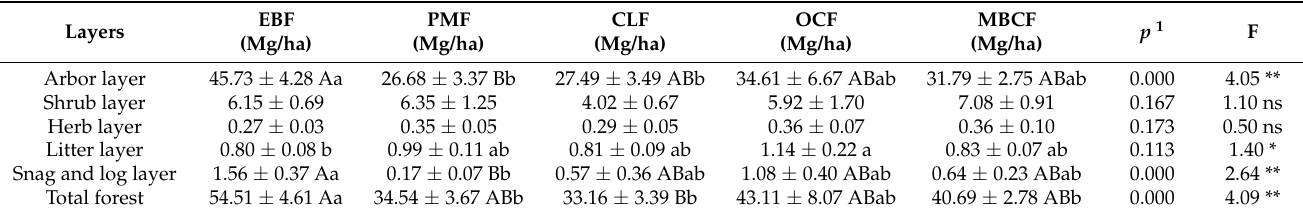
Table 6. The ANOVA and multiple comparison of vegetation carbon density (mean ± SE) in different layers among stand types.